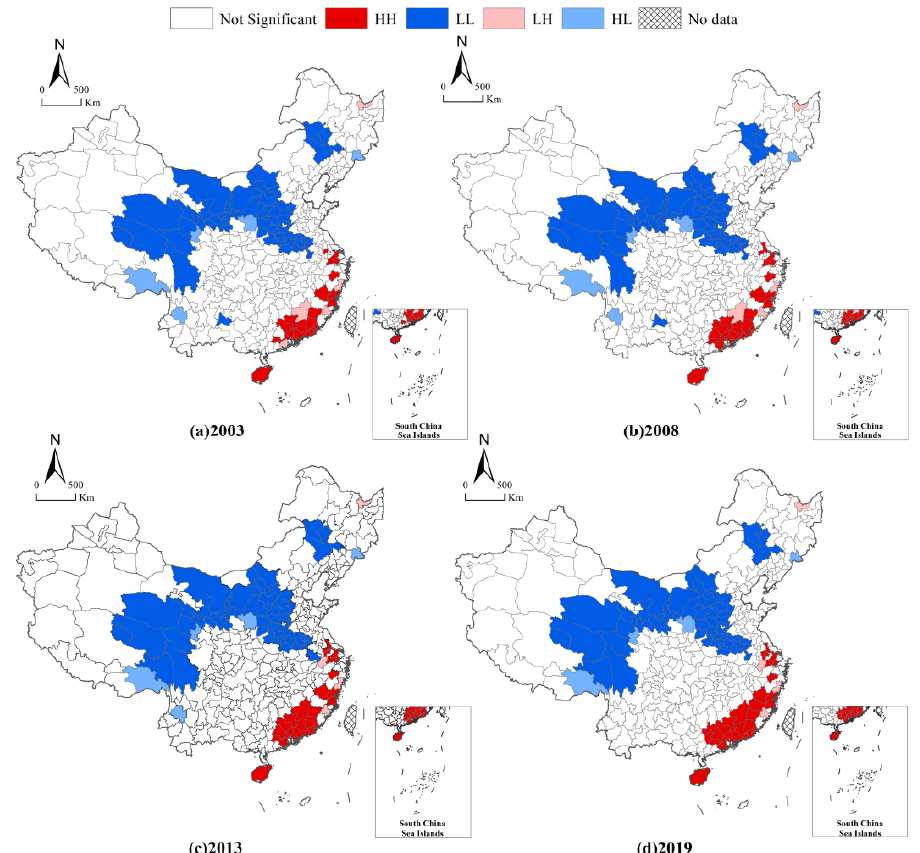
Figure 3. Spatial autocorrelation analysis results of cultivated land use efficiency in China from 2003 to 2019.